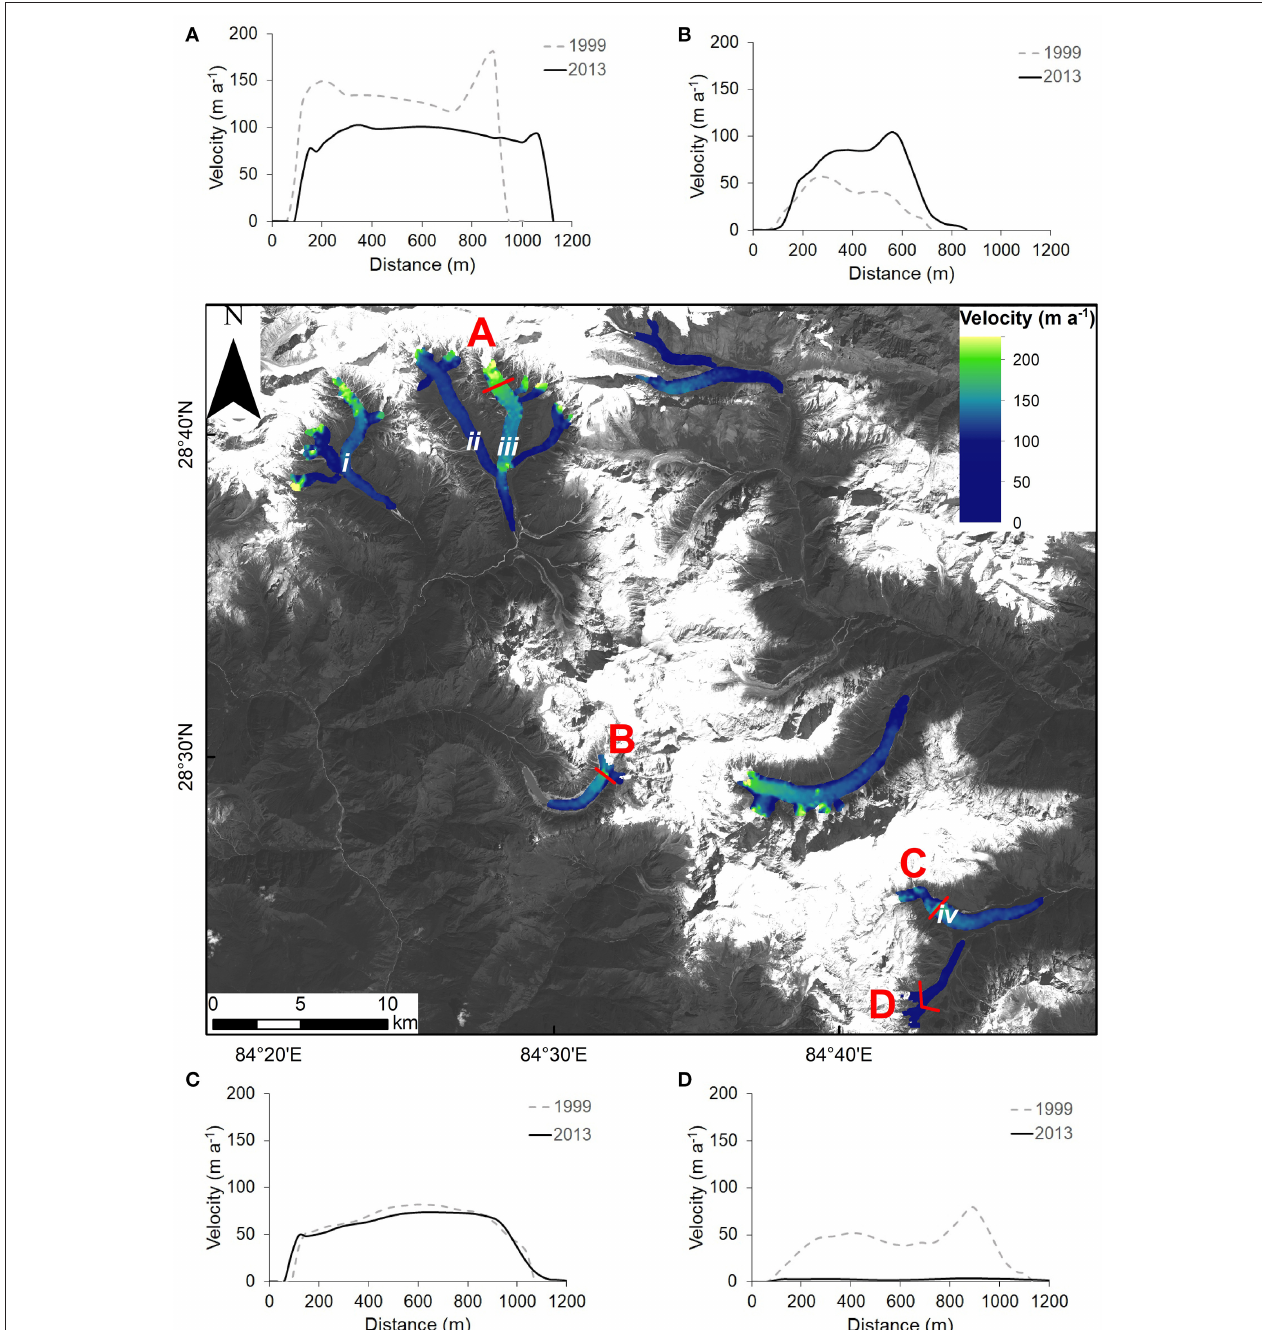
FIGURE 8 | Annual surface velocities for the glaciers in the Manaslu Region for the year 2013/2014. (A–D) Show transverse velocity profiles at the boundary where the clean ice meets the debris-covered ice (transects shown as red lines) for (A) G084459E28695N (Ponkar glacier), (B) G084549E28515N (Thulagi glacier) (C) G084695E28384N (Himal Chuli glacier), and (D) G084759E28427N (Bhauda Himal glacier). Background: Landsat 8 (26th December 2013). The markings (i–iv) relate to the longitudinal profiles shown in Figure 9 .